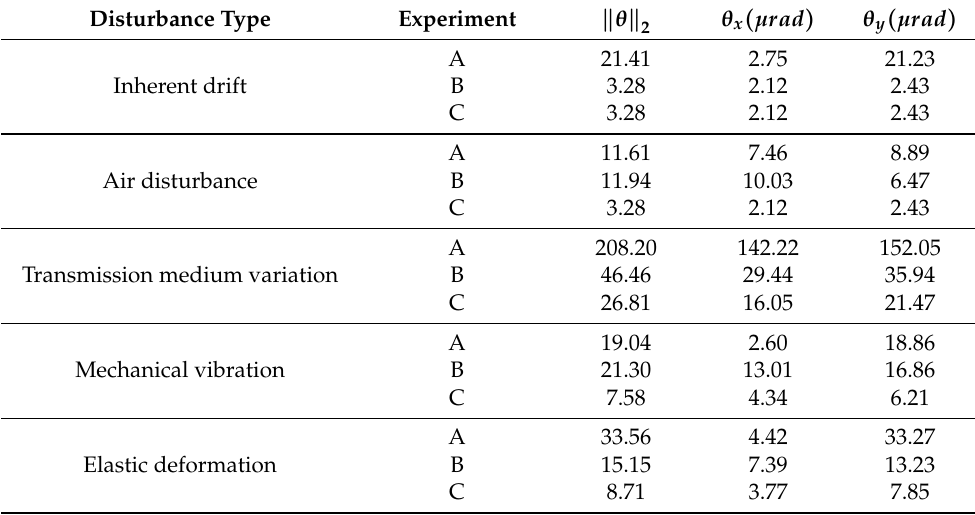
Table 2. Beam pointing instability under five disturbance types